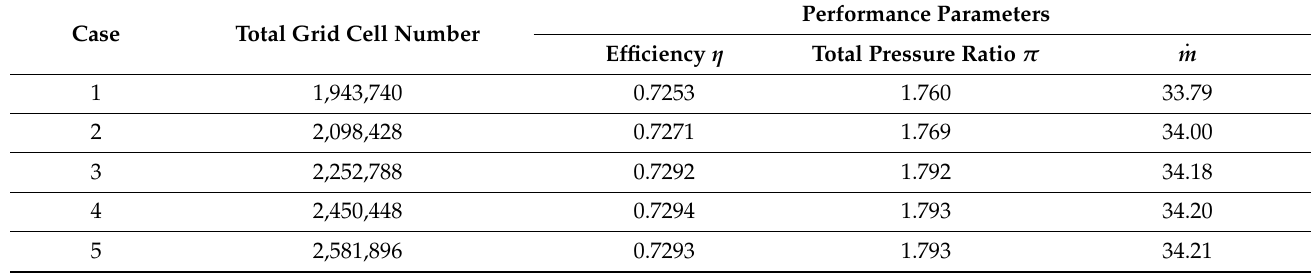
Table 3. Grid independence verification at choke condition.